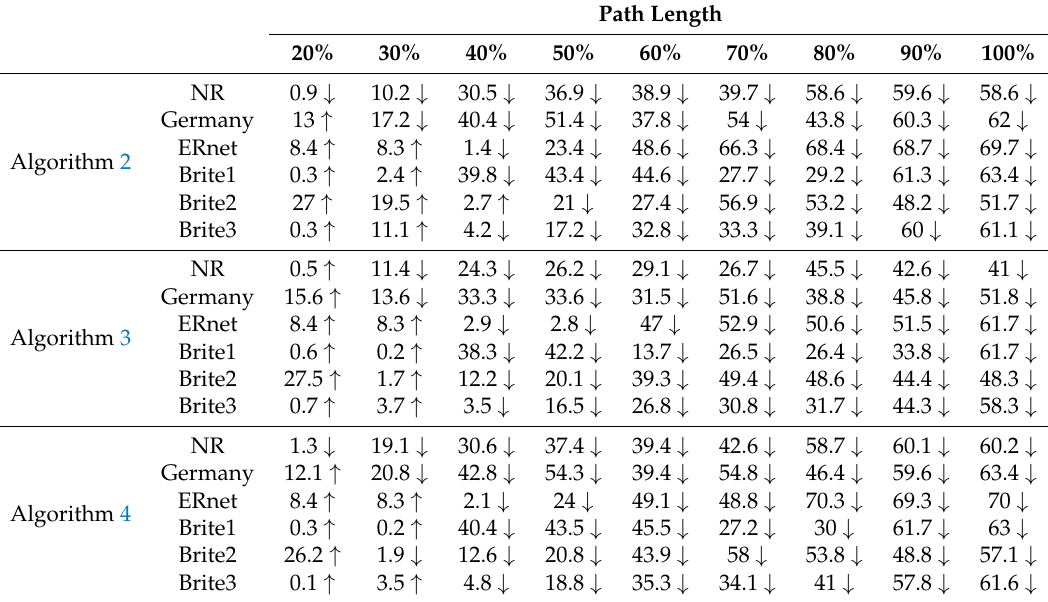
Table 5. Set-up reduction rate of Algorithms 2–4 for each topology as a function of the normalized path